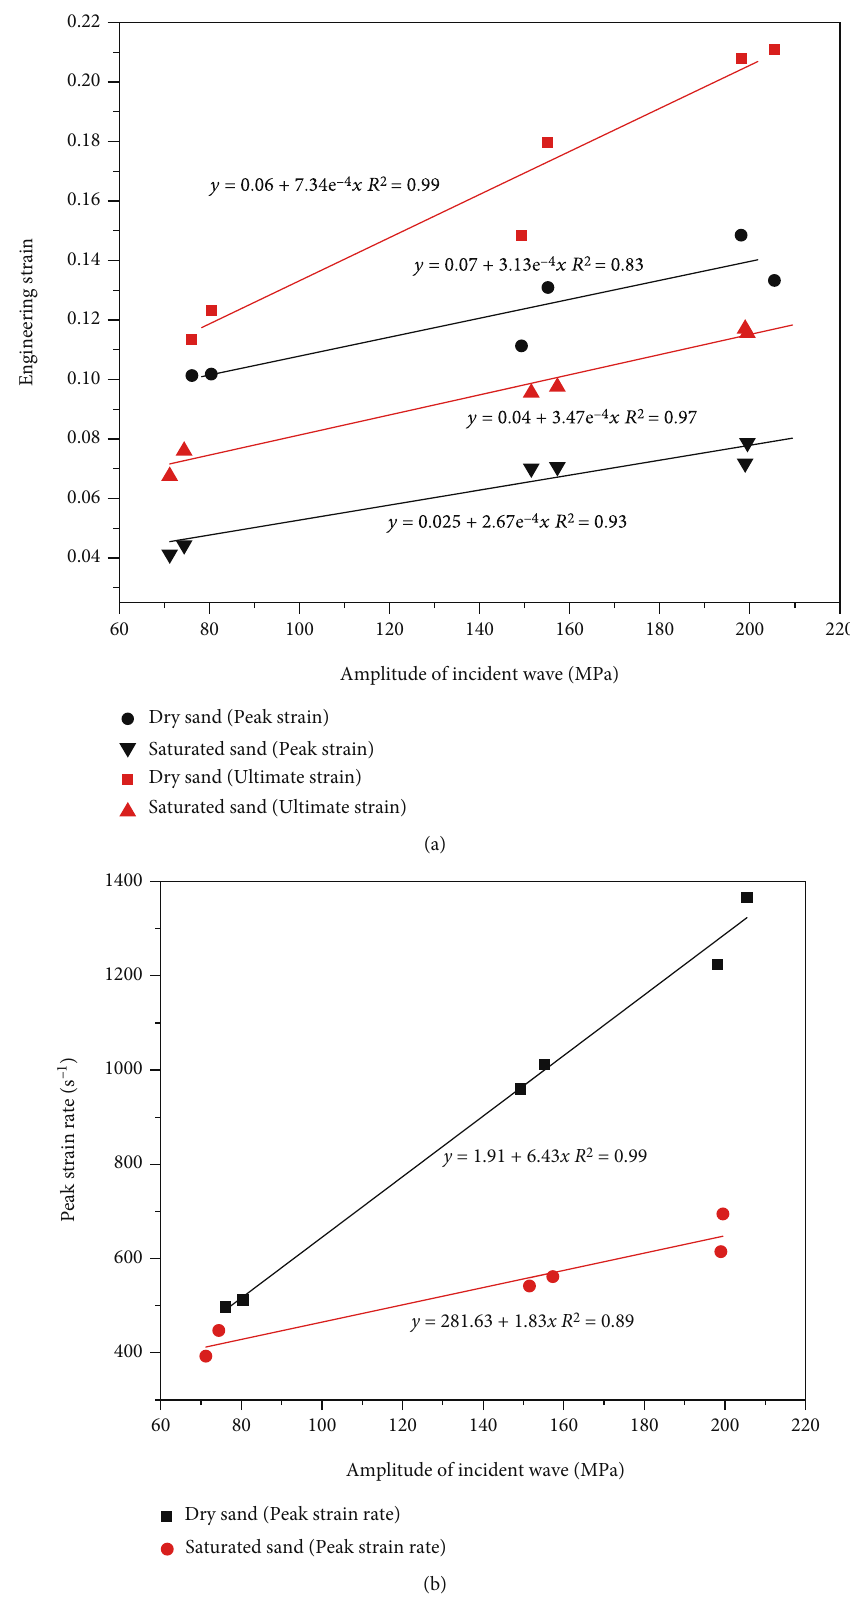
Figure 7: Variation diagram under each working condition. (a) Peak strain and ultimate strain. (b) Peak strain